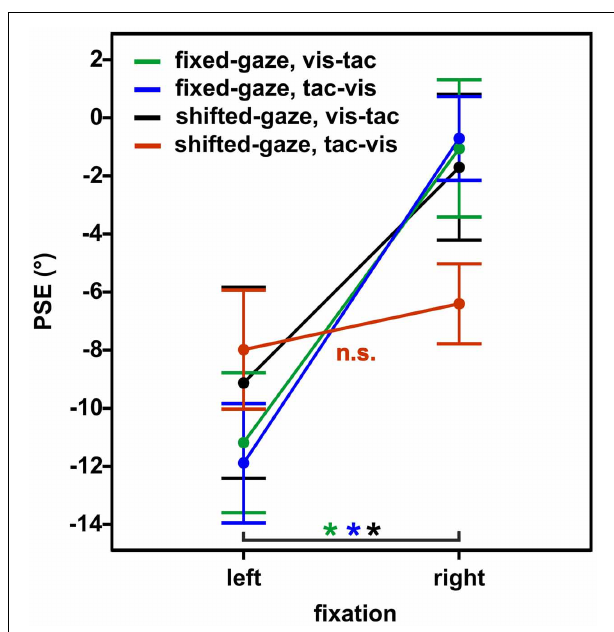
FIGURE 7 | Mean PSEs as a function of fixation, averaged across subjects for the experimental conditions (gaze condition × stimulus order). Error bars display the standard errors of the